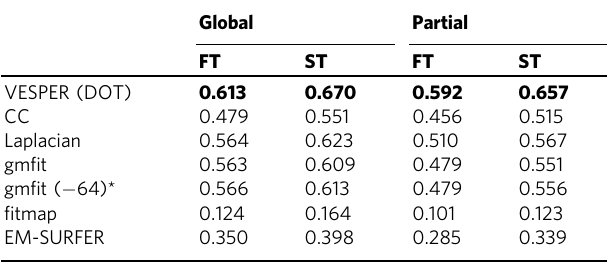
Table 1 Average fraction of correct maps retrieved within the fi rst and the second tier. Global Partial FT ST FT ST VESPER (DOT) 0.613 0.670